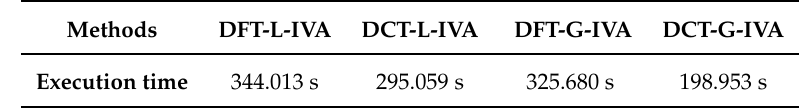
Table 5. The execution time of